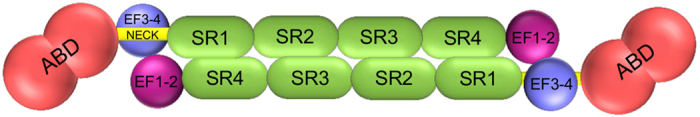
Domain structure of α-actinin-1.Domain composition of α-actinin antiparallel dimer, as inspired by the structure of human α-actinin-2 (ref. 11). ABD is shown in red, neck peptide in yellow, SR1−SR4 in green, EF1-2 in magenta and EF3-4 in violet.